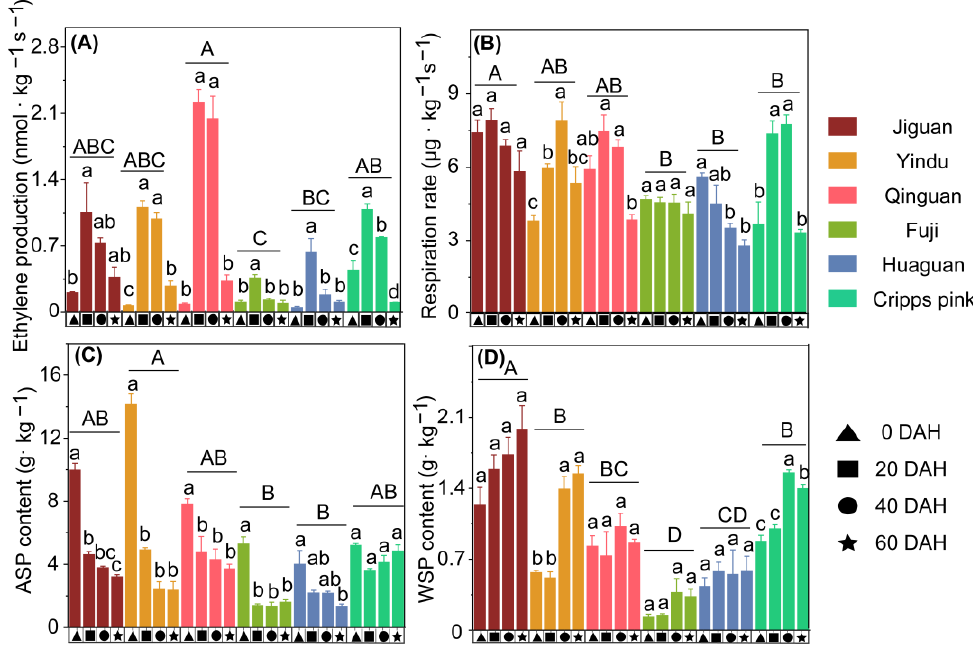
Figure 3. Ethylene production rate ( A ) and respiration rate ( B ), acid-soluble pectin (ASP) content ( C ), and water-soluble pectin (WSP) content ( D ) of ‘Jiguan’, ‘Yindu’, ‘Qinguan’, ‘Fuji’, ‘Huaguan’, and ‘Cripps pink’ apple fruit stored at 25 ± 1 °C for 60 d. Data are presented as mean ± standard error (SE) from three biological replicate assays; in each plot, the capital letters above the symbols indicate significant differences ( p < 0.05) between six cultivars, and the lowercases indicate significant differences ( p < 0.05) between different storage times.